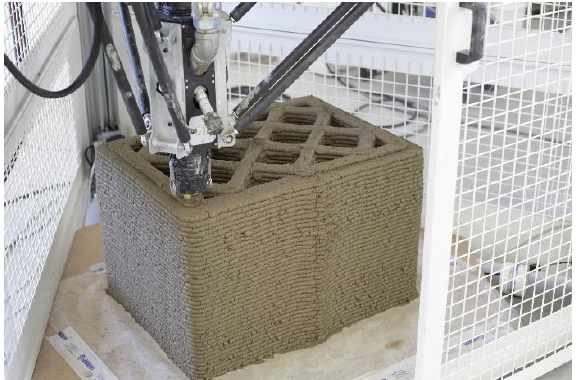
Figure 3. The 3D printing of the specimen object of this paper.